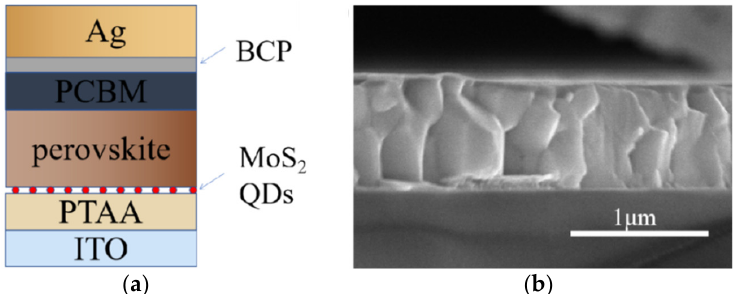
Figure 6. ( a ) A schematic diagram of the PSCs structure. ( b ) Cross-sectional SEM image of the con-